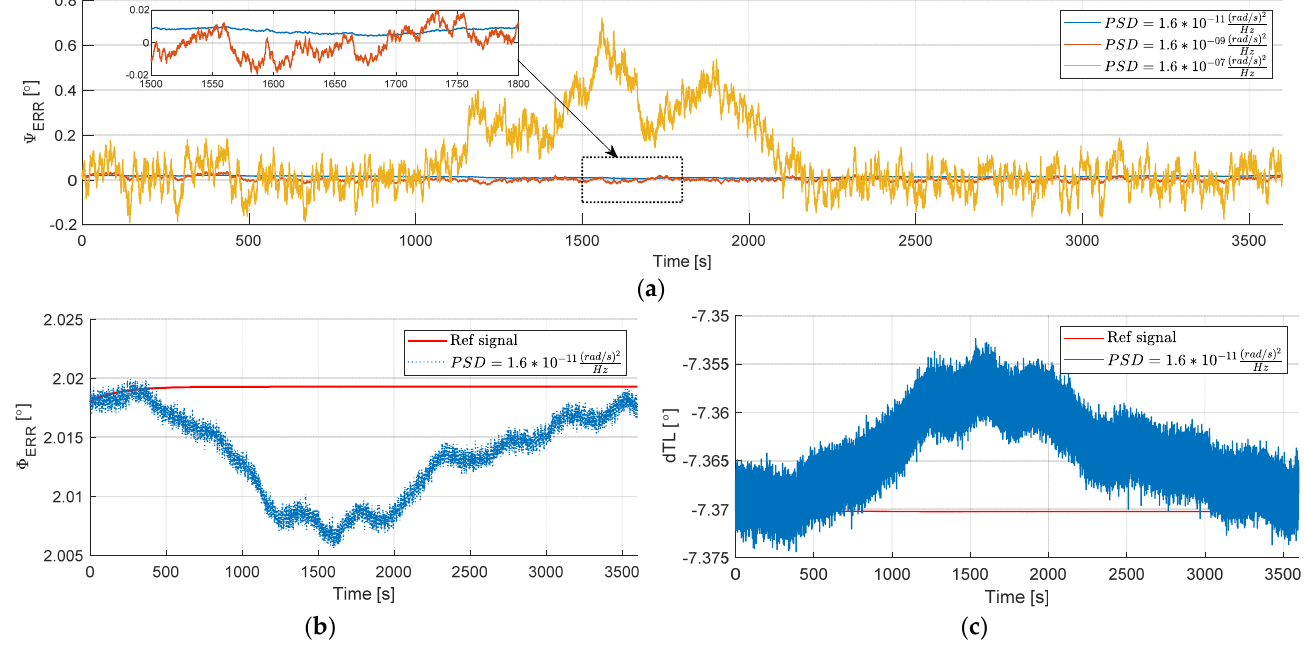
Figure 9. Influence of white noise on a stable flight: ( a ) Comparison of heading error; ( b ) Comparison of roll angle error; ( c ) Comparison of aileron trimmer deflection.